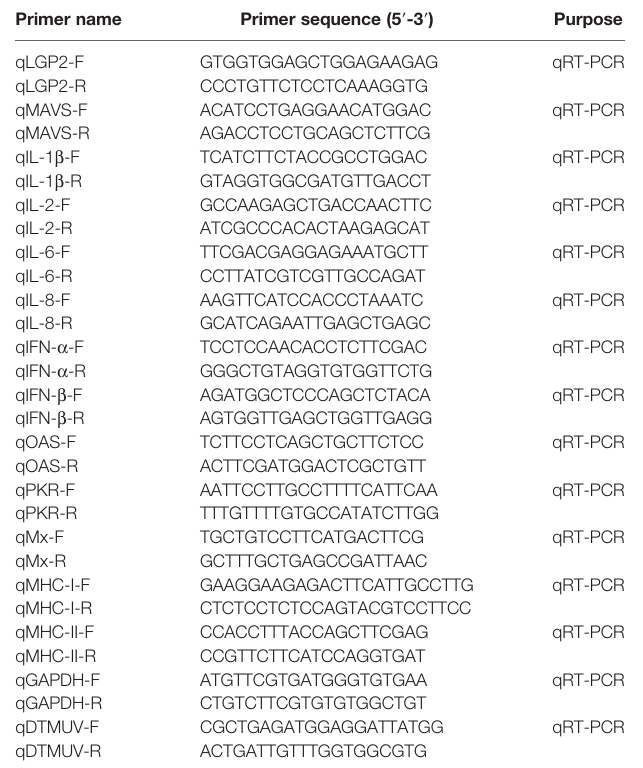
TABLE 2 | Primer sequences used in this study.